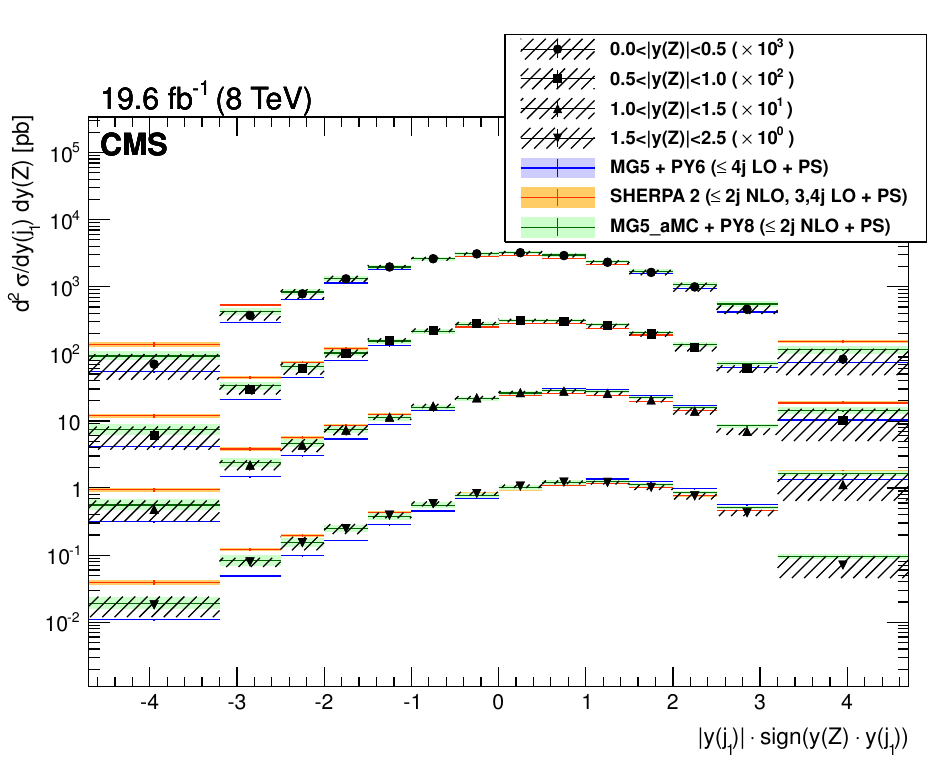
Figure 33 . The di(cid:11)erential cross section for Z ( ! ‘‘ )+jets production as a function of the Z boson and leading jet rapidity. The bands around the measurement points represent the total measurement uncertainties. The bands around the prediction points represent the total uncertainty, statistical, theoretical, and PDF components for mg5 a mc + pythia 8, and the statistical uncertainty alone for MadGraph 5 + pythia 6 and sherpa